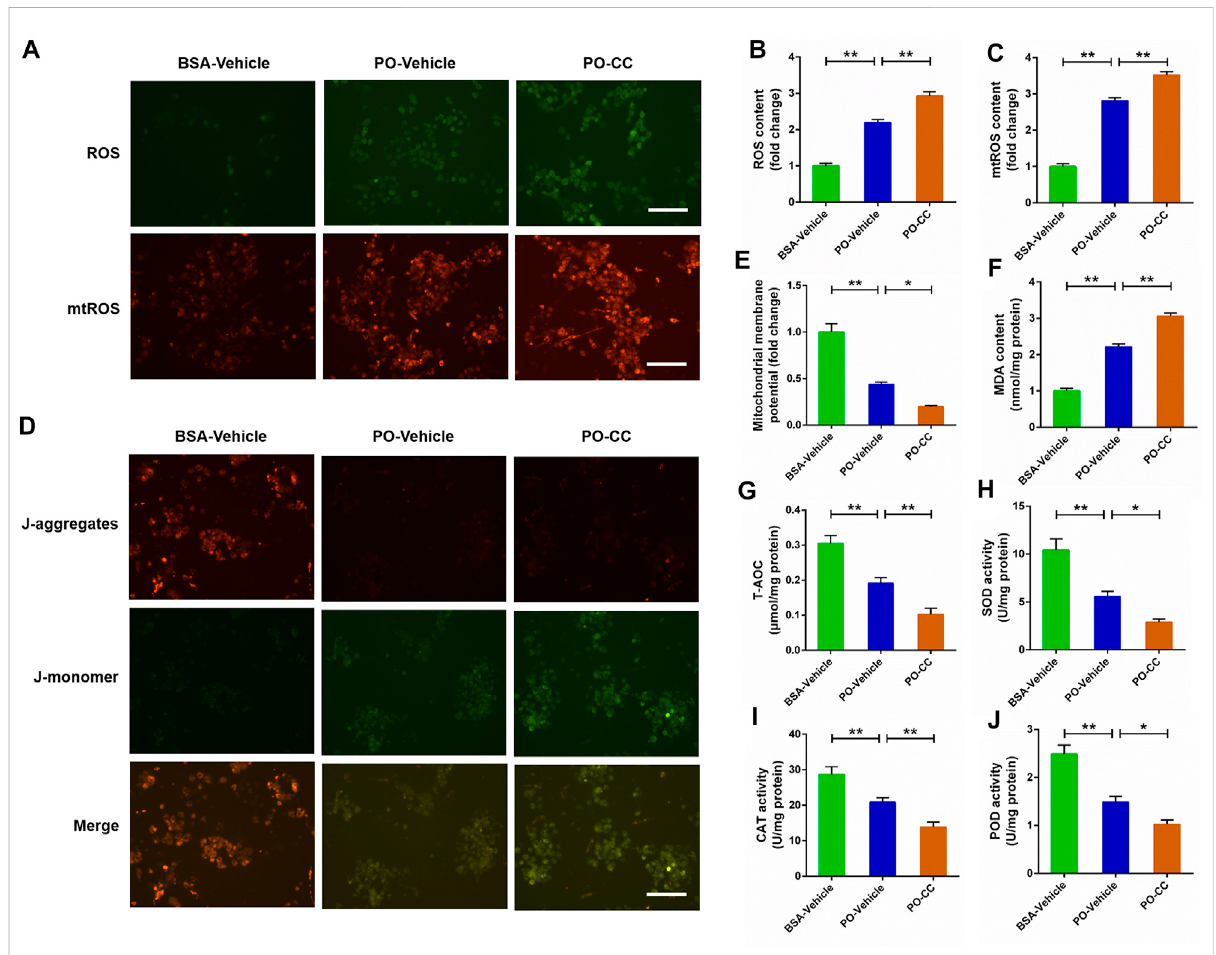
FIGURE 5 Inhibition of AMPK signal exacerbates the oxidative stress challenged by PO in primary chicken hepatocytes. The primary chicken hepatocytes were pre-treated with/without 10 μ M AMPK activator compound C for 1 h, and then stimulated with/without 0.75 mmol PO for another 24 h. (A) Fluorescencephotographyofreactiveoxygenspecies(ROS)(scalebars,100 μ m)andmitochondrialROS(mtROS)(scalebars,100 μ m); (B) Statistical analysis of ROS level; (C) Statistical analysis of mtROS level; (D) Fluorescence photography of mitochondrial membrane potential (MMP) were detectedbyJC-1(scalebars,100 μ m); (E) Statisticalanalysis ofMMP; (F) Malondialdehyde (MDA)content; (G) totalantioxidant capacity(T-AOC); (H) Superoxide dismutase (SOD) activity; (I) Catalase (CAT) activity; (J) Peroxidase (POD) activity. Values represent the means ± SE. * p < 0.05 and ** p < 0.01, signi fi cantly different between the indicated treatment